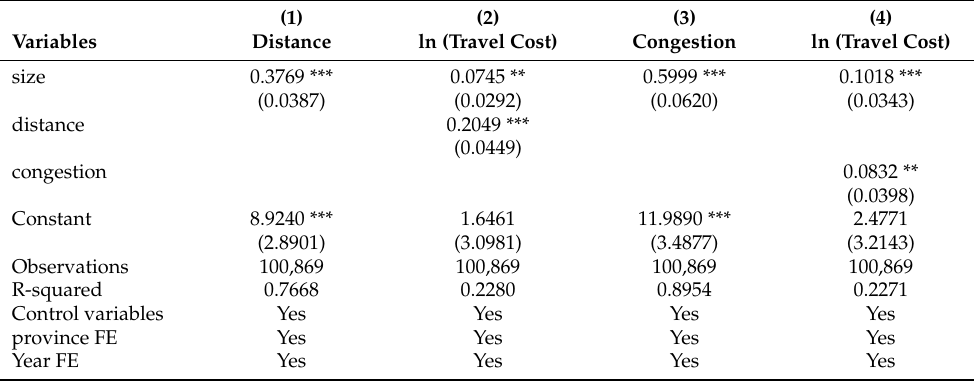
Table 5. The regression results for the mediation